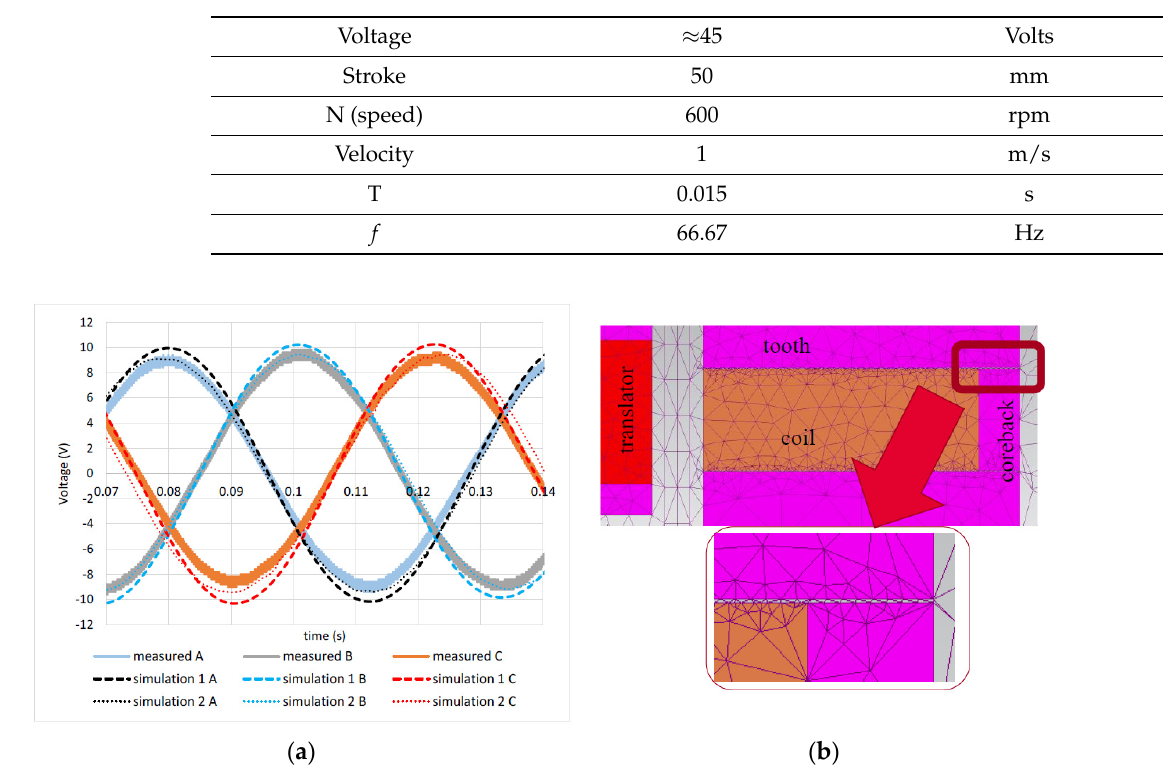
Figure 25. ( a ) Predicted (FEA) and measured (EXP) voltage at a constant speed of 0.3 m/s. Simula- tion-1 is an idealized model, Simulation-2 includes 0.05mm air gaps. ( b ) Small air gap added into the simulation to investigate possible existence of parasitic gaps .